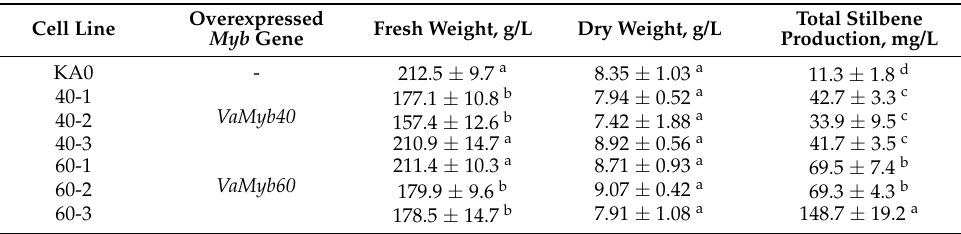
Table 1. Biomass accumulation and total stilbene production in the cell lines of Vitis amurensis overexpressing the VaMyb40 or VaMyb60